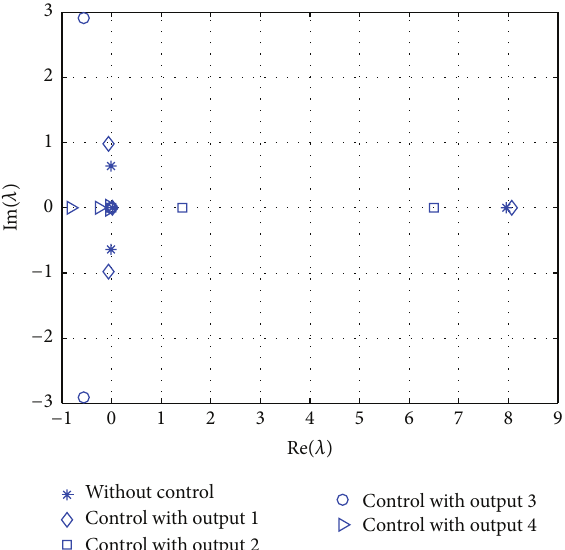
Figure 2: Eigenvalues 𝜆 of the aeroelastic model with different output controllers for flutter instability case ( 𝑈 = 16 m/s).